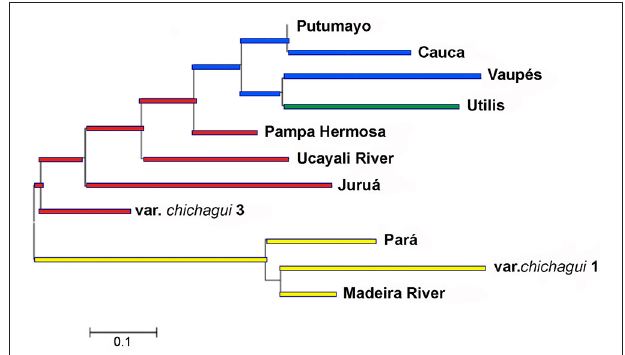
FIGURE 10 | Dendrogram based on Nei (1978) genetic distances using the Neighbor Joining algorithm to show the genetic relationships among nine domesticated populations ( B. gasipaes var. gasipaes ), the incipient domesticate (var. chichagui type 3) and one wild population (var. chichagui type 1) using 17 SSR loci and the 40 accessions in the Peach palm Core Collection at INPA, Brazil (redrawn from Cristo-Araújo et al., 2013). Clusters are colored according to the Structure groups in Figure 7C